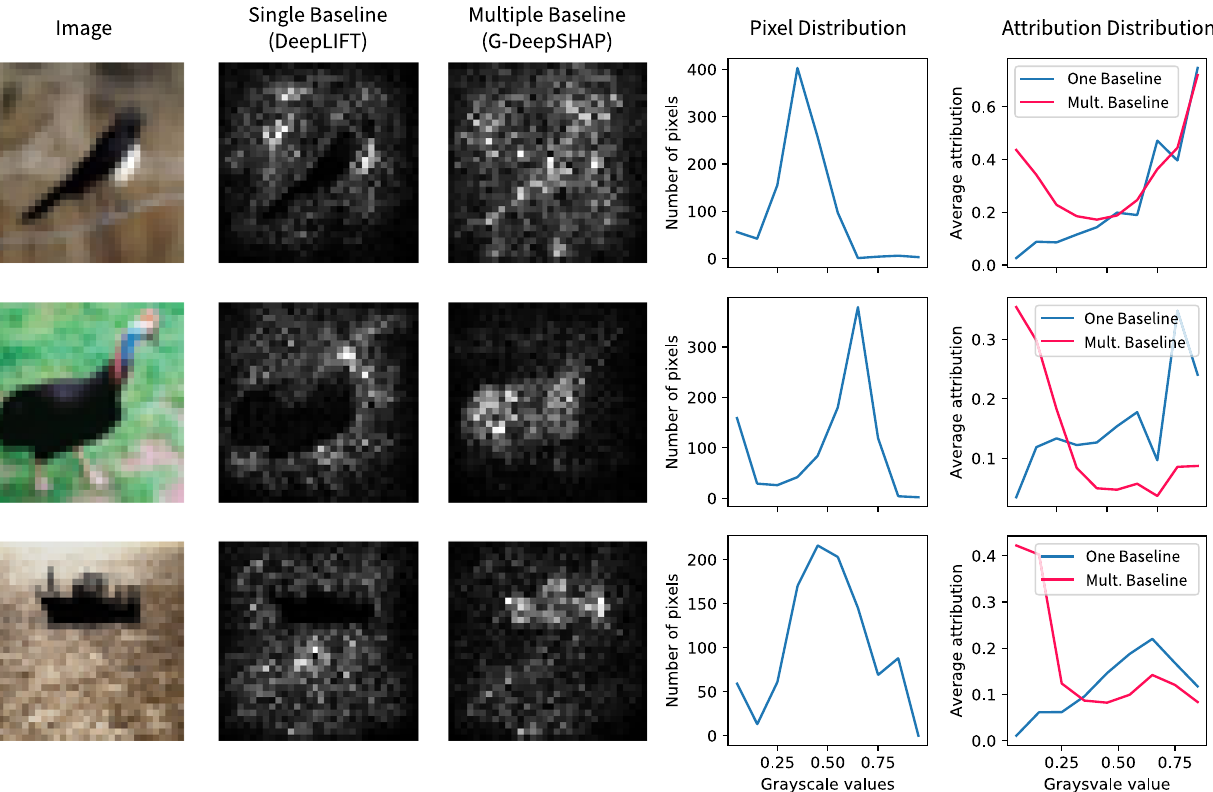
Fig. 2 Using a single all-black baseline image (DeepLIFT) leads to biased attributions compared to attributions with a randomly sampled baseline distribution (G-DeepSHAP). The image is the explicand. The attribution plots are the sum of the absolute value of the feature attributions for the three channels of the input image. The pixel distribution is the distribution of pixels in terms of their grayscale values. The attribution distribution is the amount of attribution mass upon a group of pixels binned by their grayscale